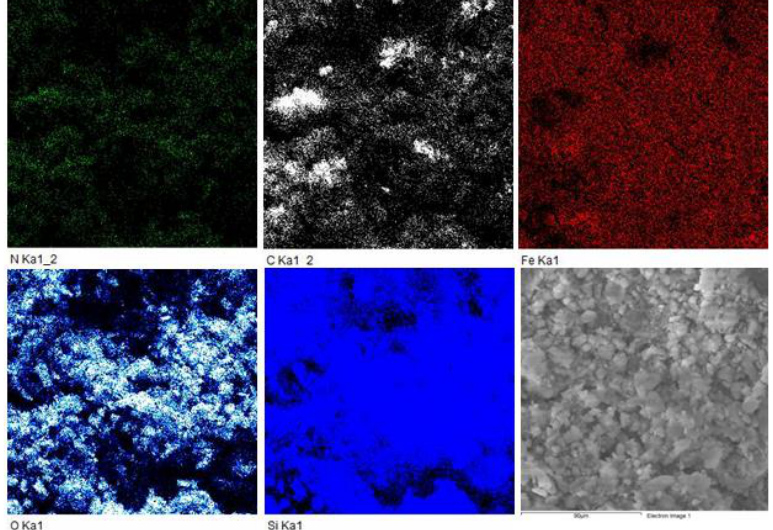
Figure 4. SEM-EDS spectra of ( a ) Fe 2 O 3 -SiO 2 nanocomposite and ( b ) Fe 2 O 3 -SiO 2 -PAN.